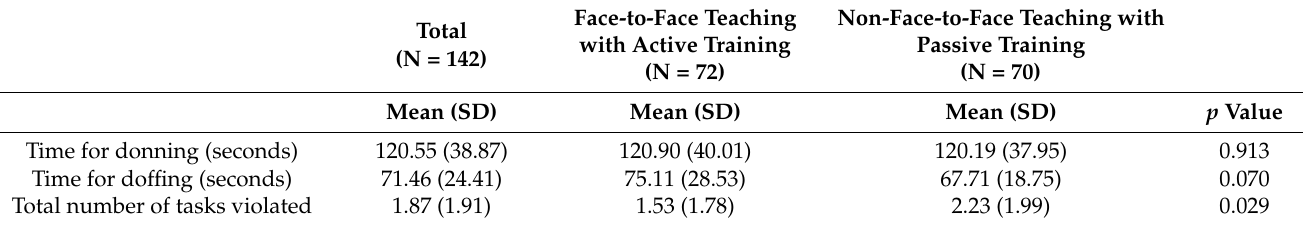
Table 5. Time needed to accomplish the protocol in both donning and doffing and the total number of tasks violated between both training